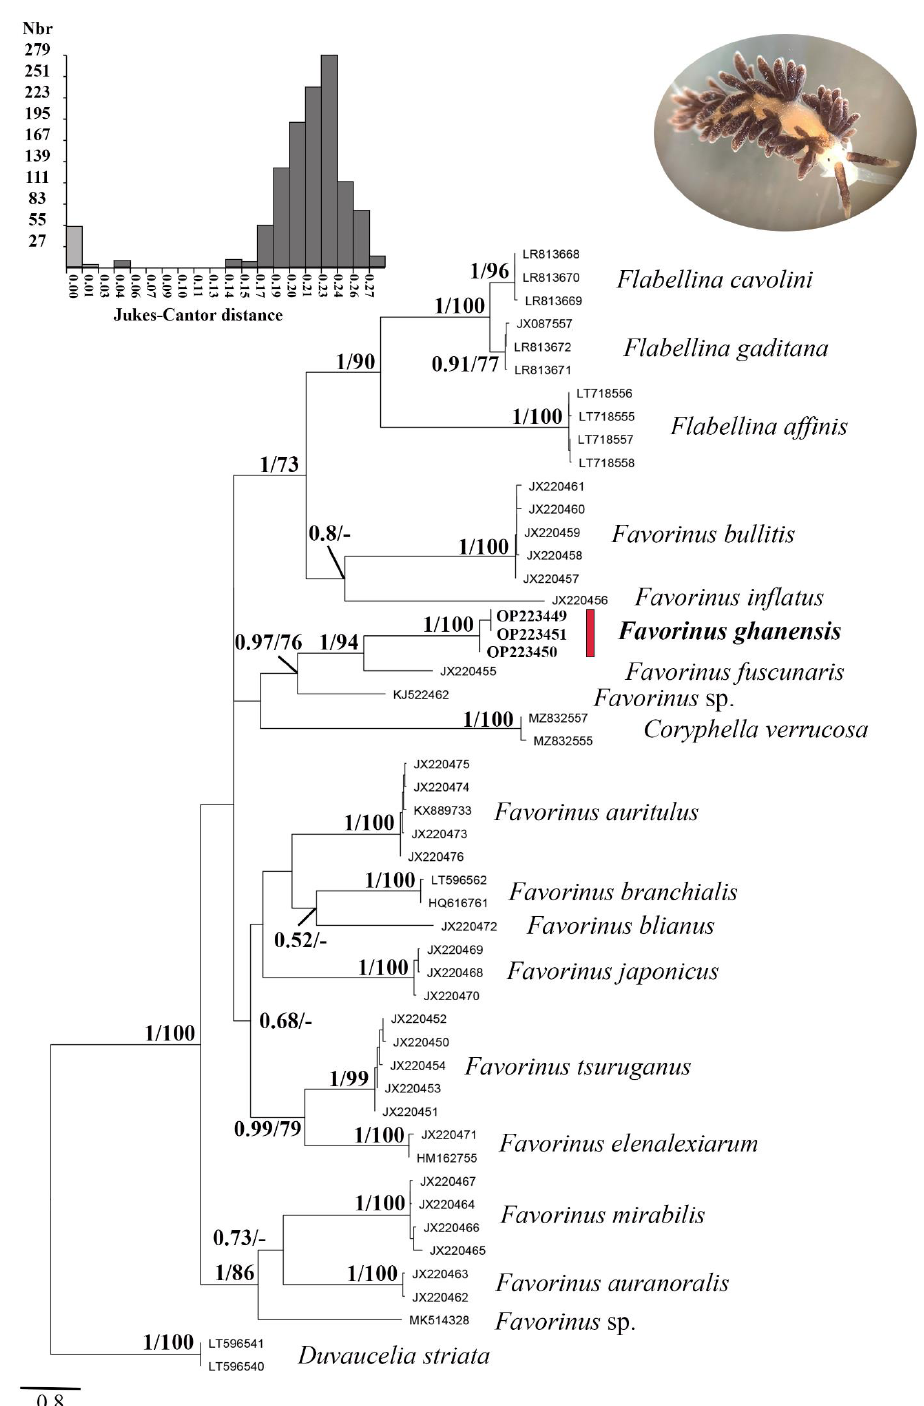
Figure 3. Maximum likelihood topology based on the COI dataset with results from species delimi- tation analyses (left, top). Numbers at nodes indicate Bayesian posterior probability (BPP; left) of the BI and bootstrap support (BP; right) from the ML. BPP < 0.50 and BP < 50% were not reported. The histogram in the upper left part shows the distribution of the pairwise genetic distances (JC69) in intraspecific (left, light grey) and interspecific (right, dark grey) comparisons. The red-colored rectangle highlights F. ghanensis specimens. The ‘-’ symbol indicates unsupported